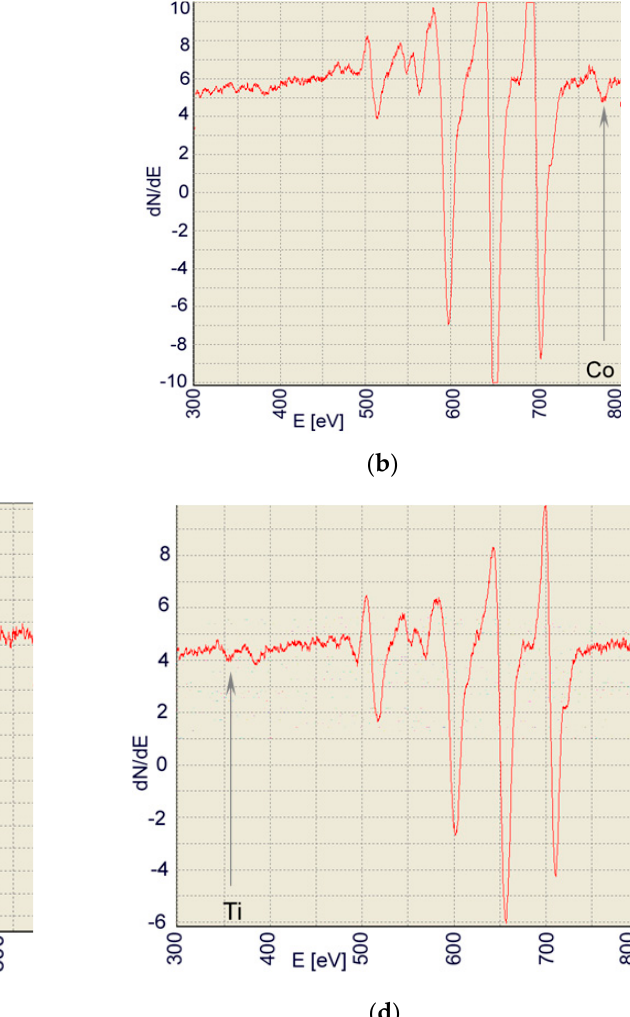
Figure 10. Dimensions of the melted zone and the alloyed zones after laser alloying with silicon, cobalt, silicon nitride, and titanium using the same laser beam parameters.